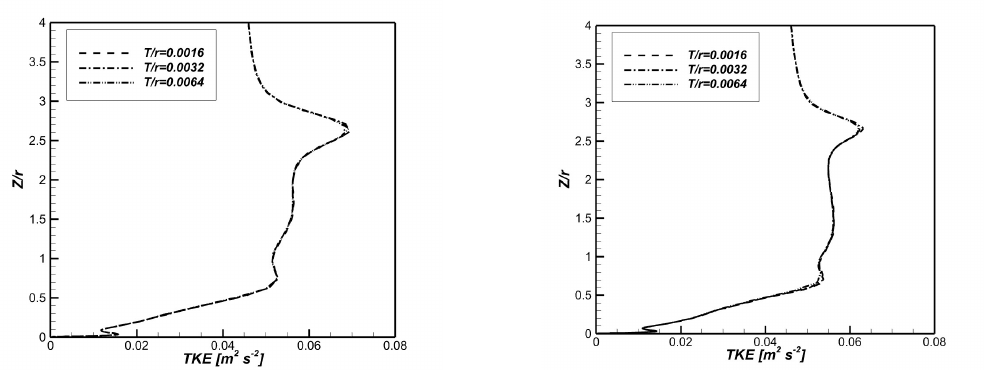
Figure 10. Turbulence kinetic energy (m 2 /s 2 ) at 1 D ( left ) and 2 D ( right